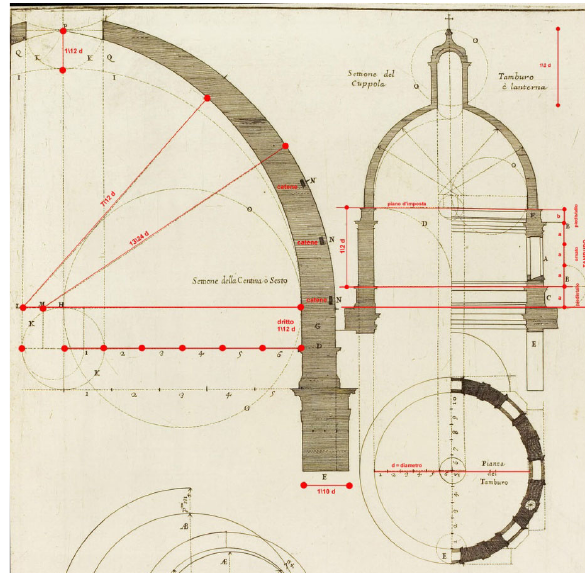
Figure 4. Carlo Fontana, Dimostrazioni e regole per costruire le Cupole semplici e Dimostrazioni e regole per costruire le Lanterne"